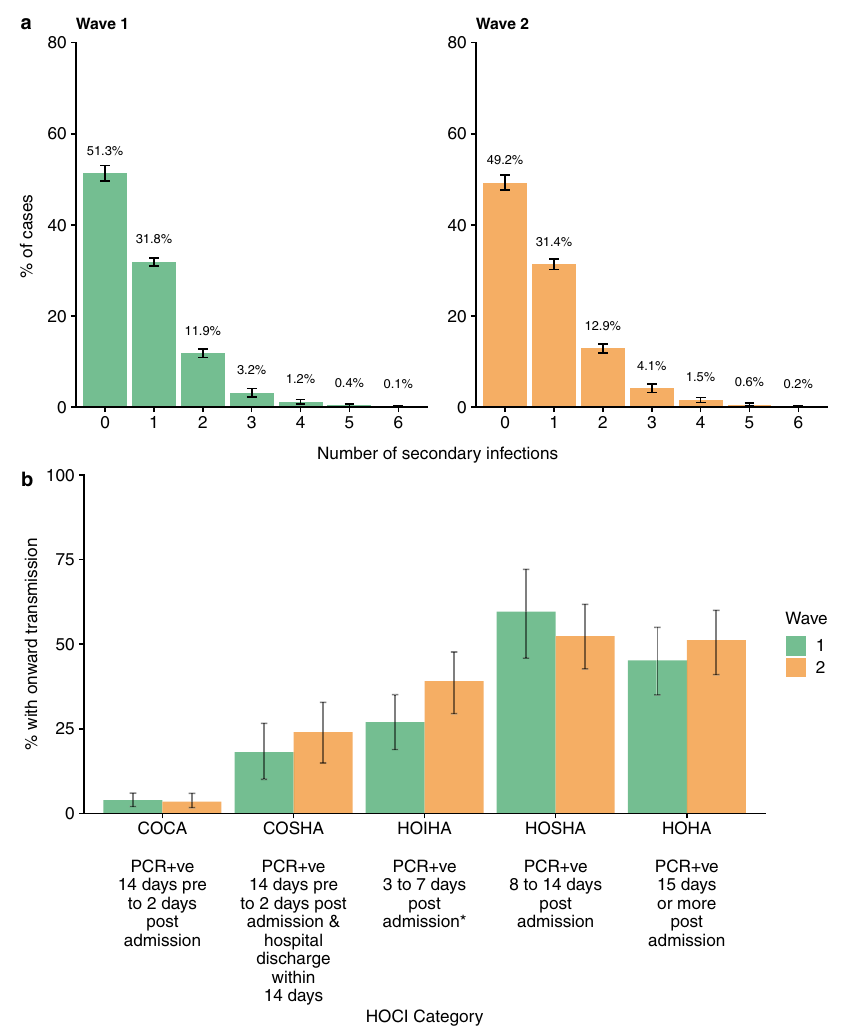
Fig. 4 Secondary cases distributions and onward infections by Hospital Onset COVID19 Infection category. a the percentage of cases with each number of secondary cases after adjusting for cases involved in transmissions but not represented in the dataset. b The percentage of each HOCI category